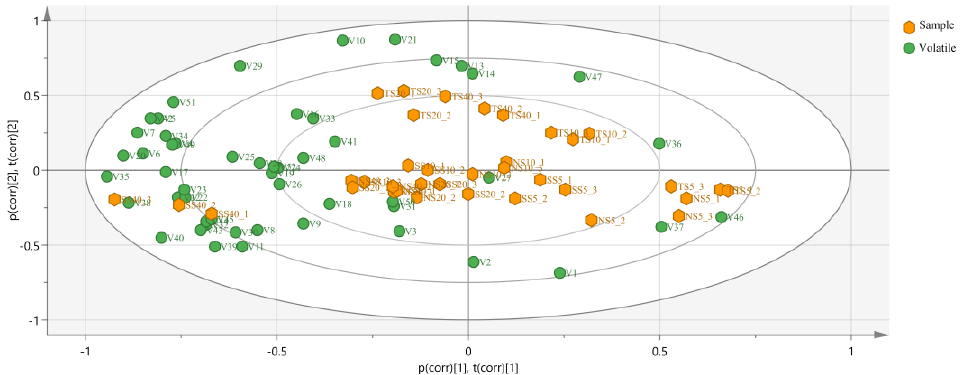
Figure 4. The biplot of volatile flavor compounds correlated with different processing techniques based on OPLS − DA in salted herrings.